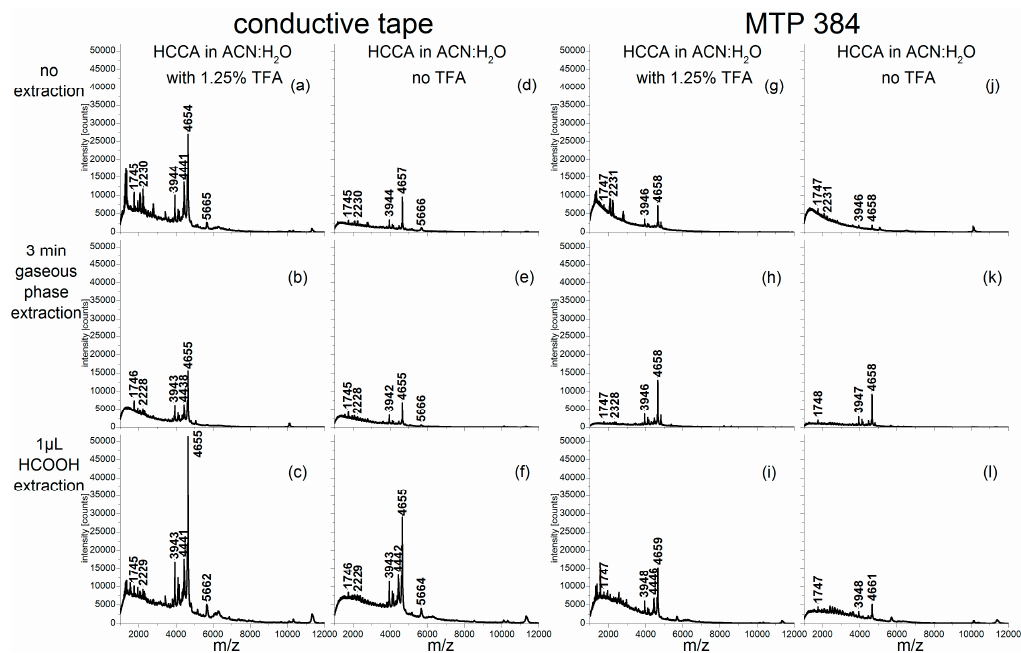
Figure A3. Averaged MALDI-TOF mass spectra ( n = 5) of Pinus sylvestris pollen grains: measured on conductive tape with TFA in the matrix solution ( a – c ), on conductive tape without TFA in the matrix solution ( d – f ), on the steel target (MTP 384) with TFA in the matrix solution ( g – i ) and on the steel target without TFA in the matrix solution ( j – l ) (in the rows: extraction procedure).